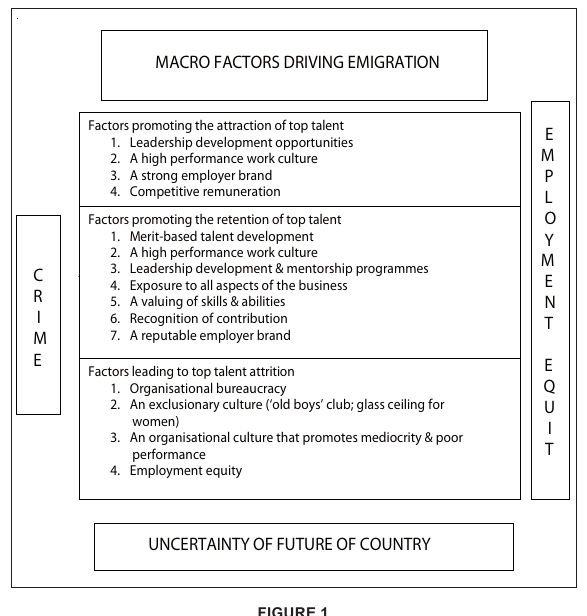
fIgurE 1 Factors influencing talent attraction, attrition, retention and